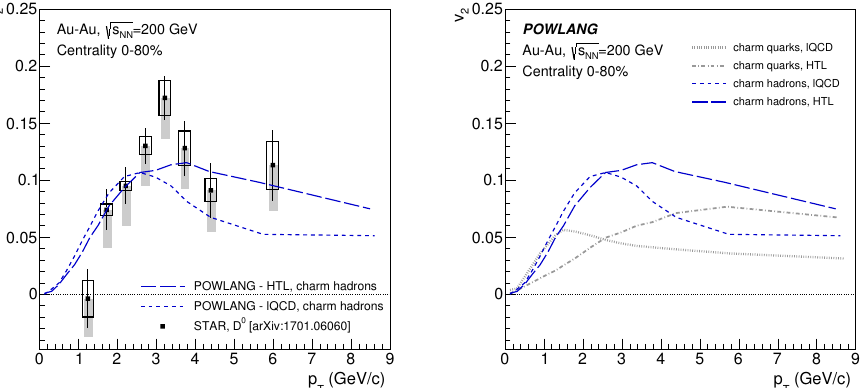
p s NN = 200 GeV. Our